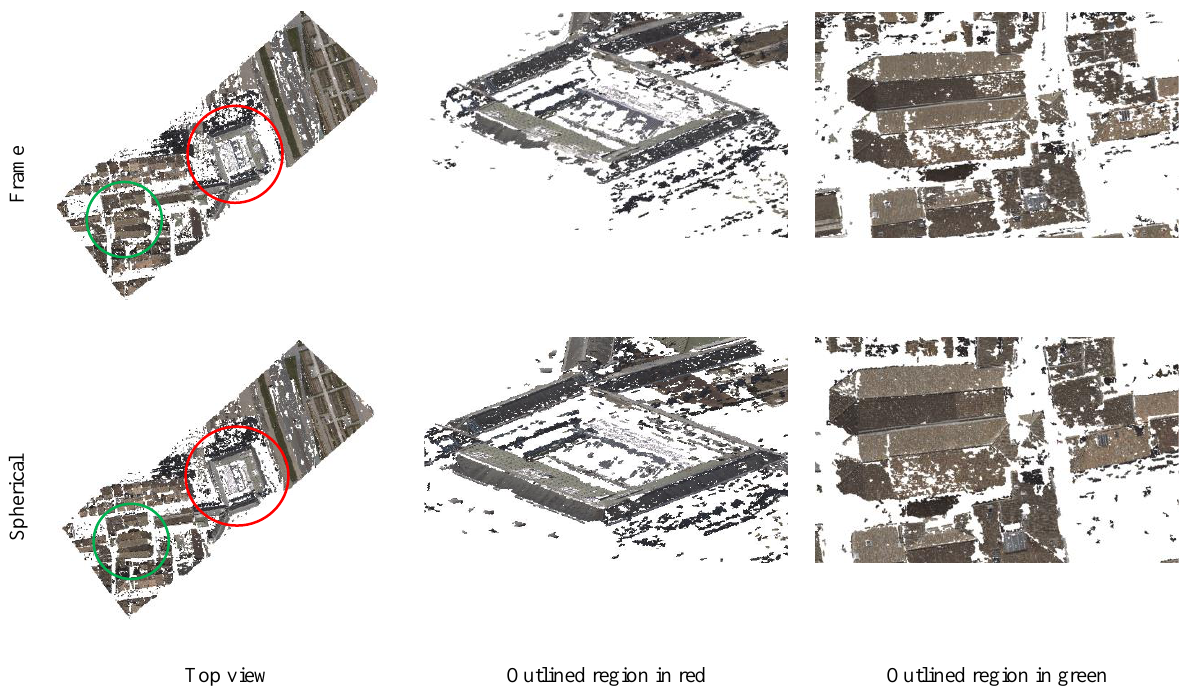
Figure 4 . Generated point clouds using the frame-based rectification (first row) compared to the proposed approach using the proposed spherical model. The circled regions give examples of the more complete point cloud produced using the proposed approach compared to frame-based.